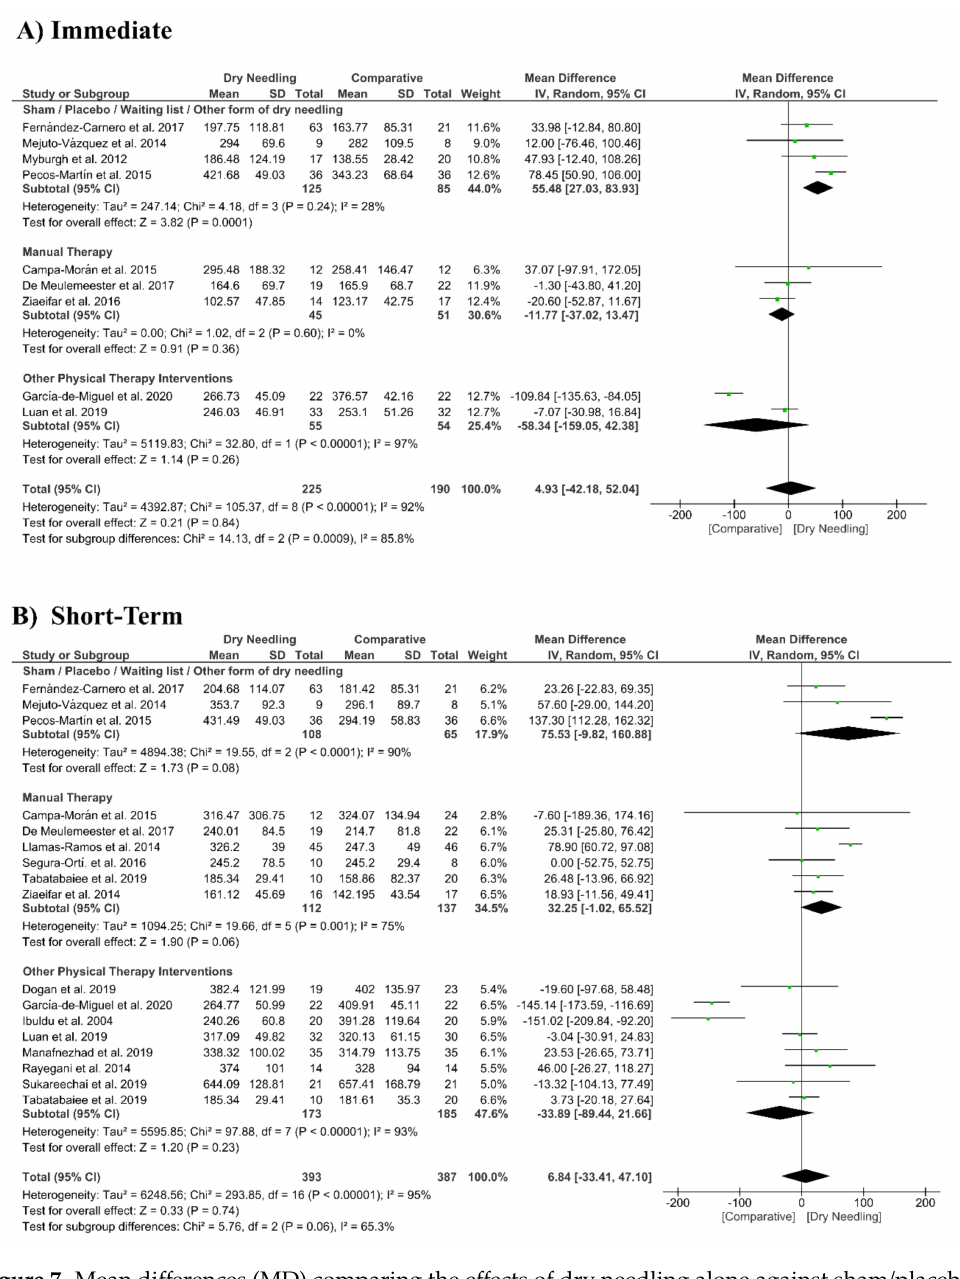
Figure 7. Mean di ff erences (MD) comparing the e ff ects of dry needling alone against sham / placebo / waiting list / other forms of dry needling or manual therapy or other physical therapy interventions on the pressure pain thresholds (kPa) ( A ) immediately after and ( B ) at the short-term. SD: standard deviation; CI: confidence